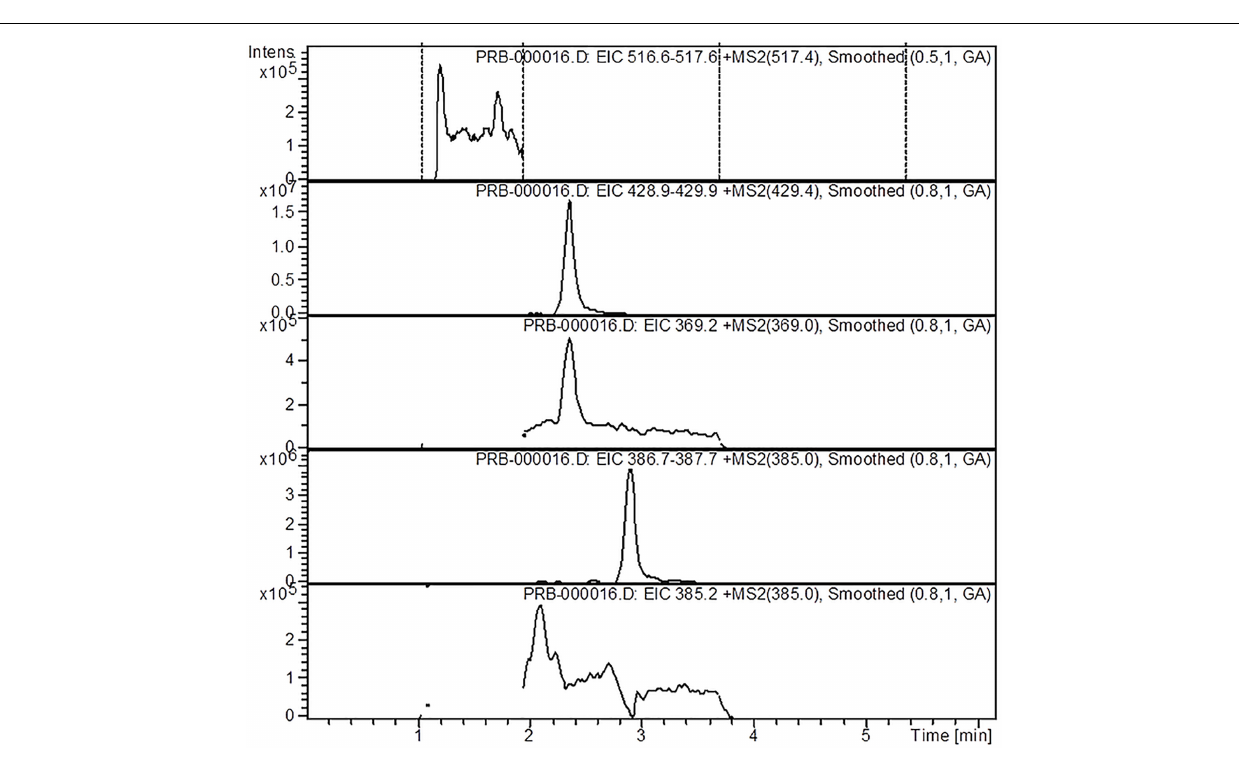
FIGURE 3 | HPLC-MS-MS chromatogram of iridoids from A. chamaepitys ethanol